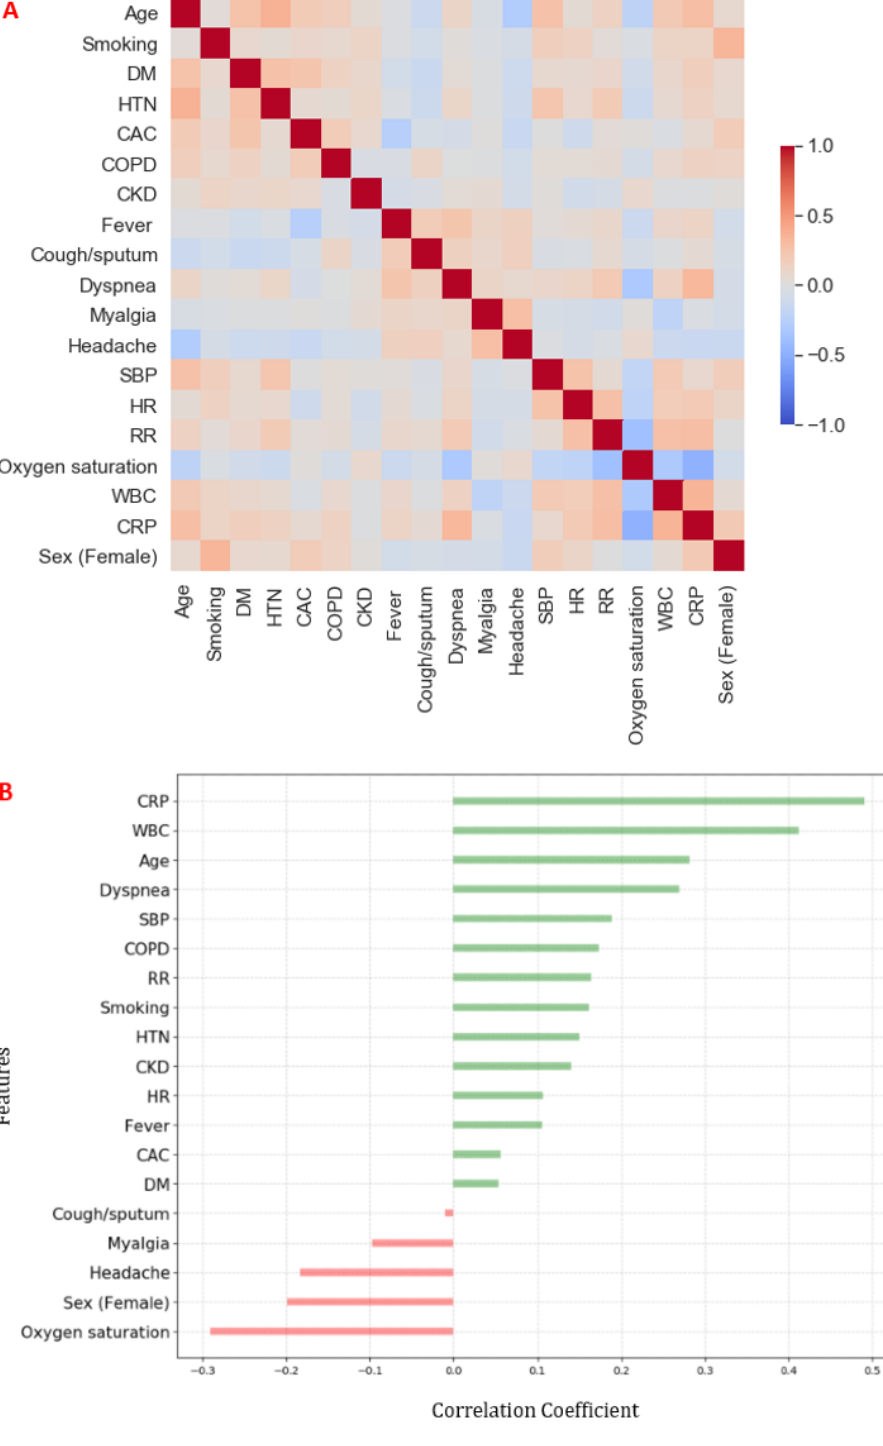
Performances of Deep Learning Models: ANN Versus CNN Versus